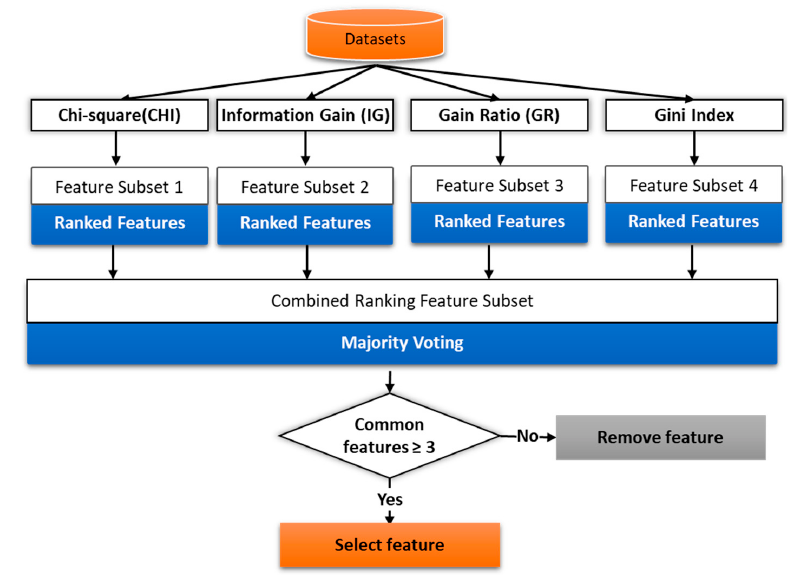
Figure 9. Filter base feature selection process.